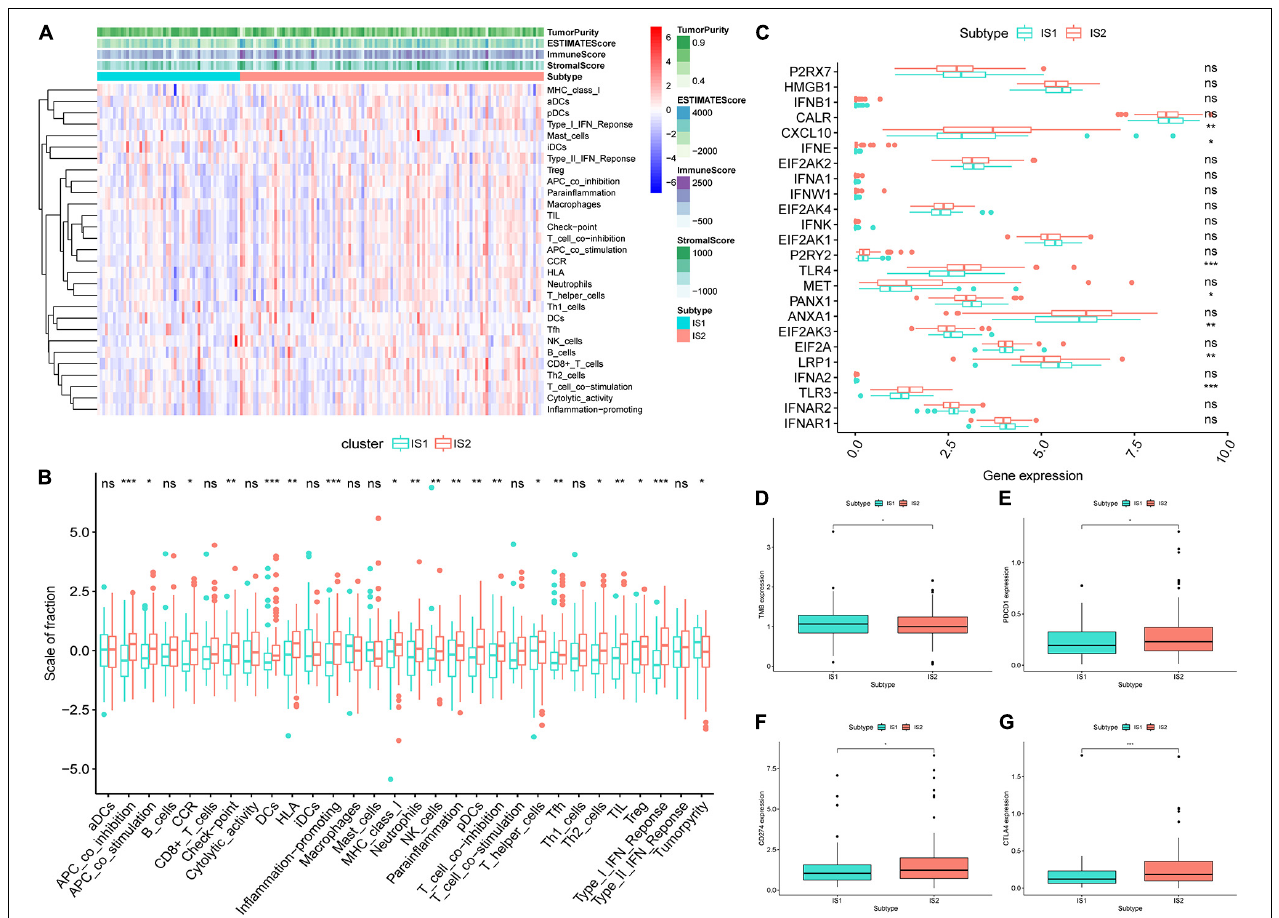
FIGURE 6 | Features of tumor immune microenvironment (TIME) in different immune subtypes. (A) Based on the results of single-sample gene-set enrichment analysis (ssGSEA) of 29 immune-related hallmarks and pathways in GBM samples, heatmap showed the different levels of tumor purity, ESTIMATE score, immune score and stromal score, and the distribution of enrichment scores (ESs) of each sample in IS1 and IS2. The darker the color, the greater the absolute value of the score. (B) The difference analysis of ES of each sample changes among IS2 and IS2 was shown in the boxplots. (C) Different expression levels of immune checkpoint (ICP) genes in IS1 and IS2. (D) The difference analysis of tumor mutational burden (TMB) between IS1 and IS2. Difference analysis of (E) PDCD1, (F) CD274, and (G) CTLA4 among two subtypes. *** p < 0.001, ** p < 0.01, * p < 0.05, ns: not